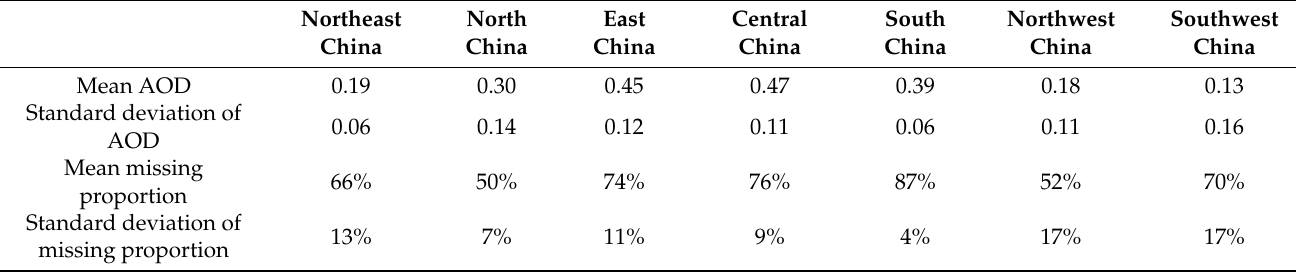
Table 2. Mean and regional means of AOD and its missing proportion for 2015–2018 in mainland